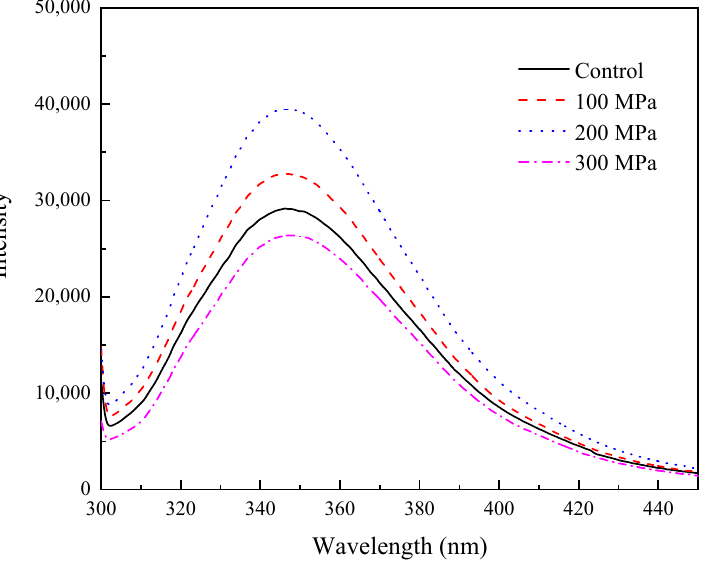
Figure 11. Effect of HHP pretreatment on the intrinsic fluorescence spectrum of RBPH. HHP: high hydrostatic pressure; RBPH: rice bran protein hydrolysates. Control, 100 MPa, 200 MPa, and 300 MPa represent RBPH samples subjected to 0, 100, 200, and 300 MPa pretreatment, respectively. All the HHP pretreatments were conducted at 25 °C for 30 min.